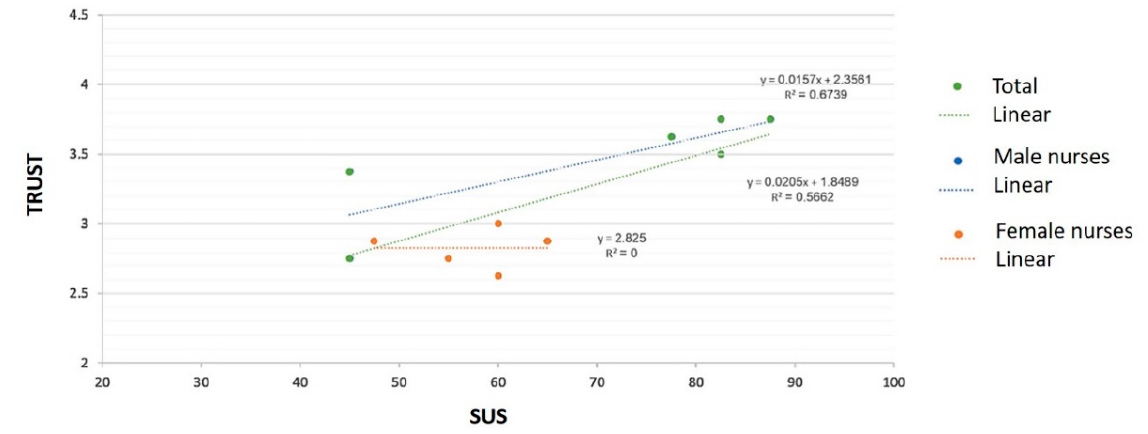
Figure 15. Correlation between SUS score and users’ trust level.